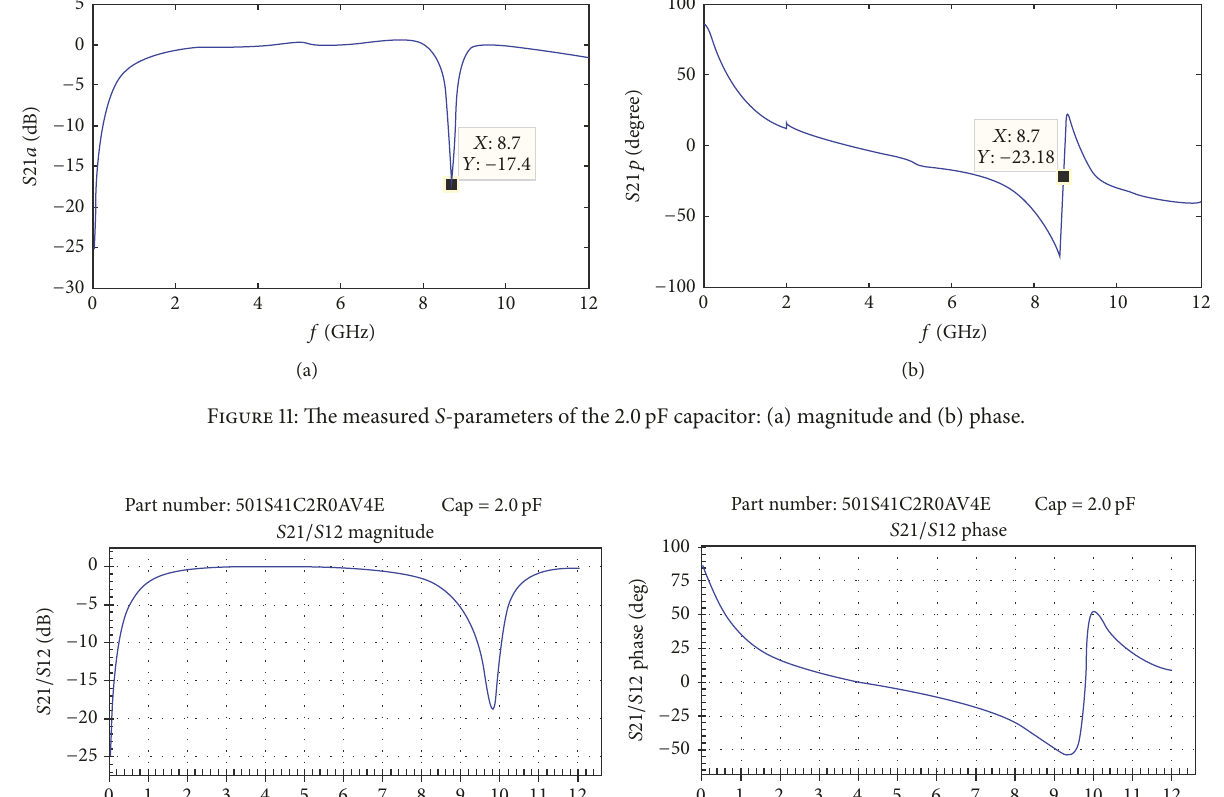
becomes negative, which indicates that the capacitor is now in fact an inductor. Therefore, for SMD capacitors, they can only be used under their series resonant frequencies in real